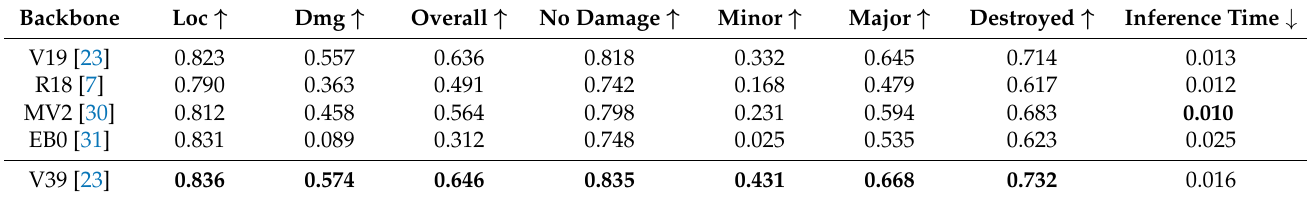
Table 2. Comparative studies with various backbones for building damage assessment (BDA). The fusion operator is fixed to addition. The VovNet methods achieve a better overall F1 score than other backbones, while the inference time is